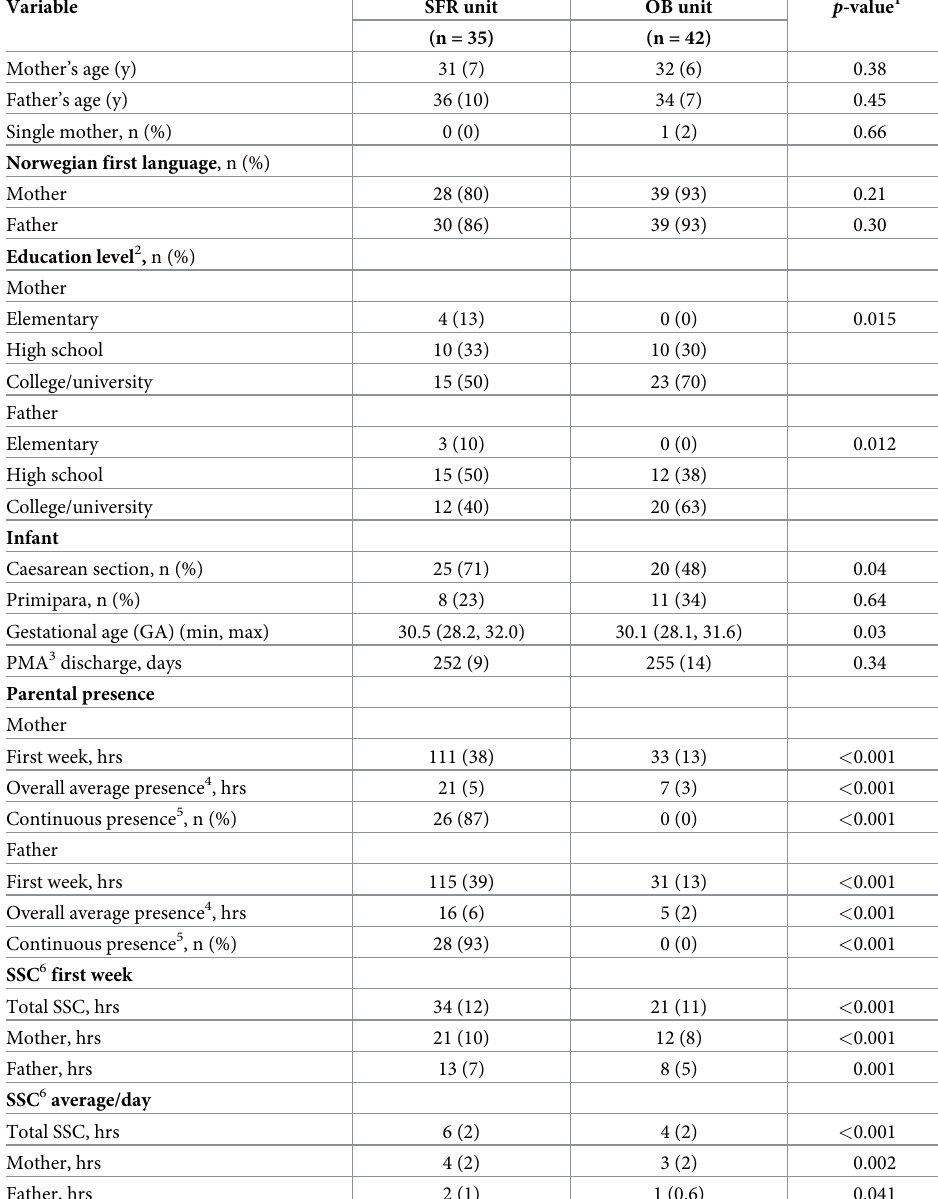
Table 1. Characteristics of the families and infants cared for in the single-family room (SFR) and open-bay (OB) units presented as means (SDs) or number (%) within each unit. Variable SFR